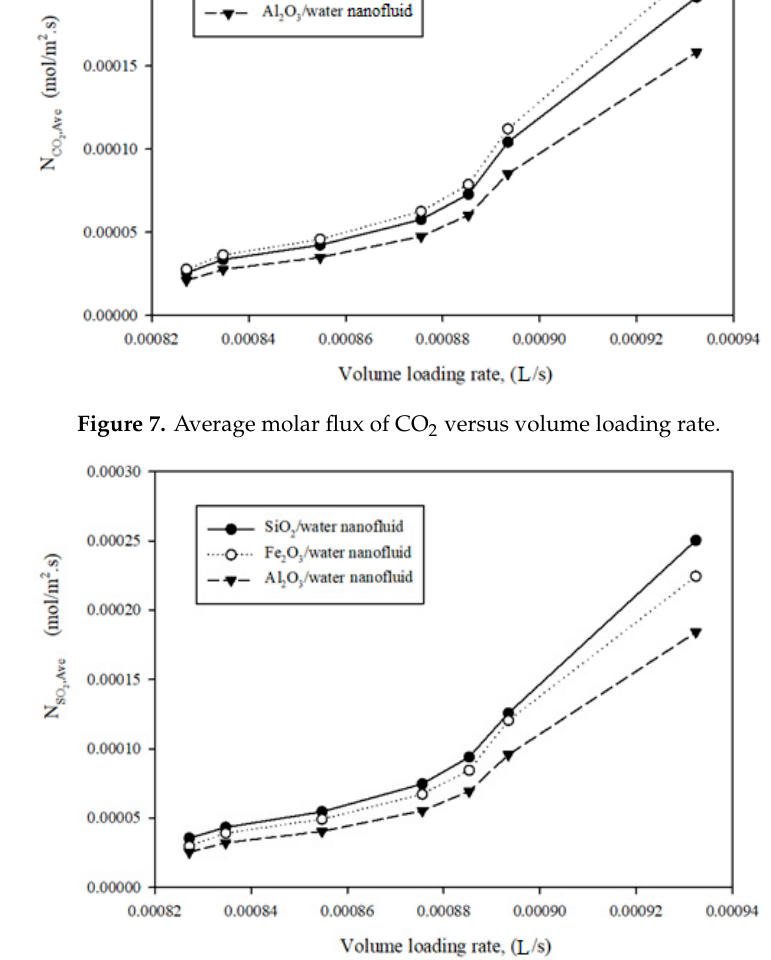
Figure 8. Average molar flux of SO 2 versus volume loading rate.